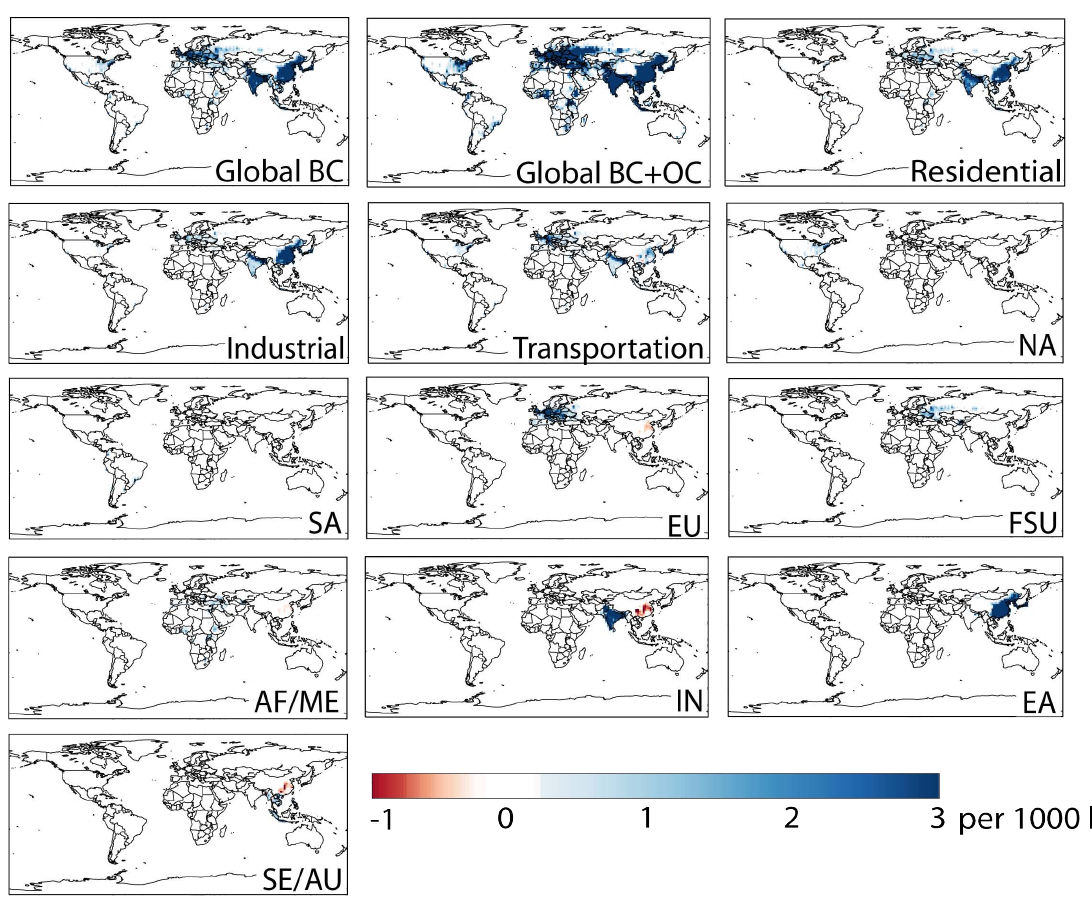
Fig. 6. Avoided annual cardiopulmonary and lung cancer deaths per 1000km 2 , for the global, sectoral, and regional emission reductions relative to the base